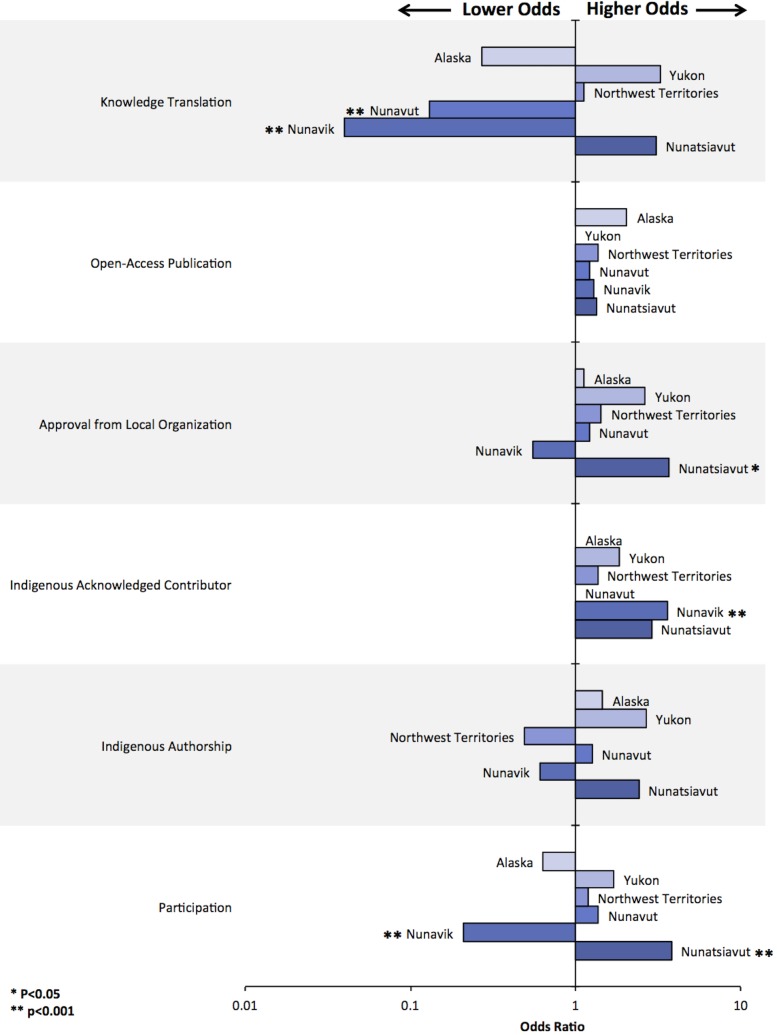
Multivariable exact logistic regression examining associations between location and various indicators of community-engaged research.